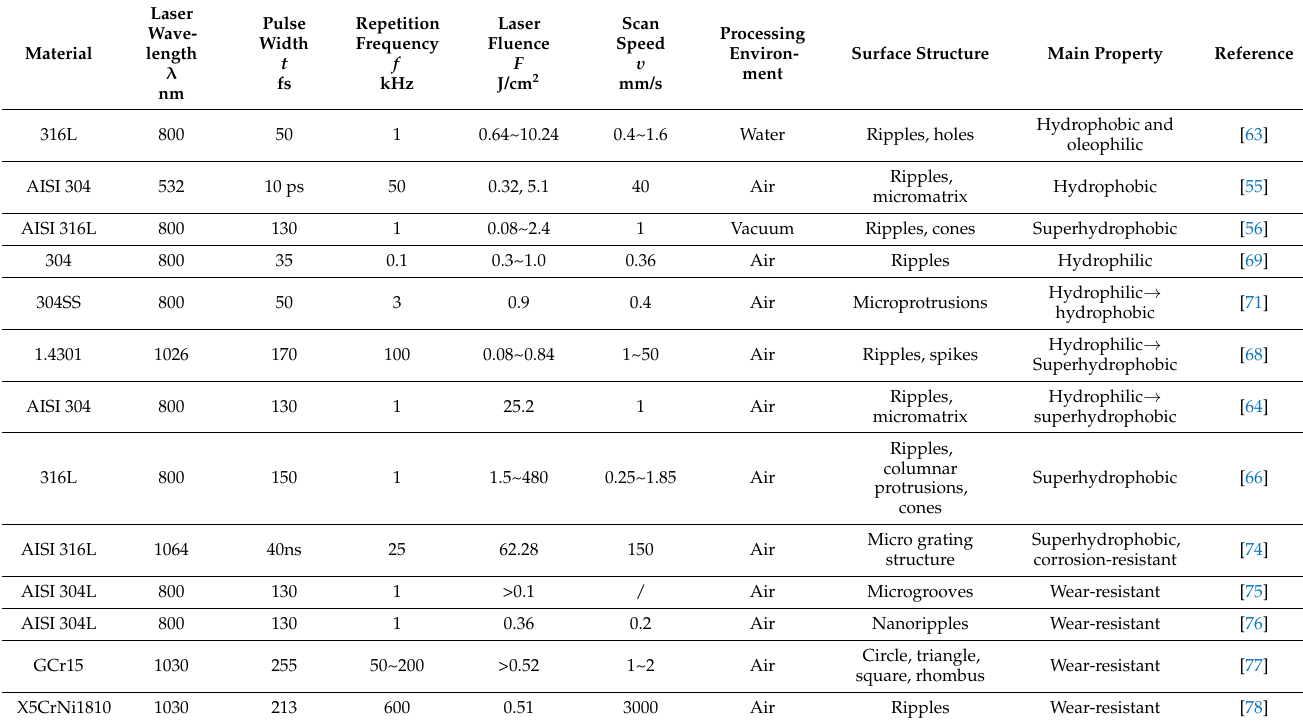
Table 3. Surface structure and performances of test